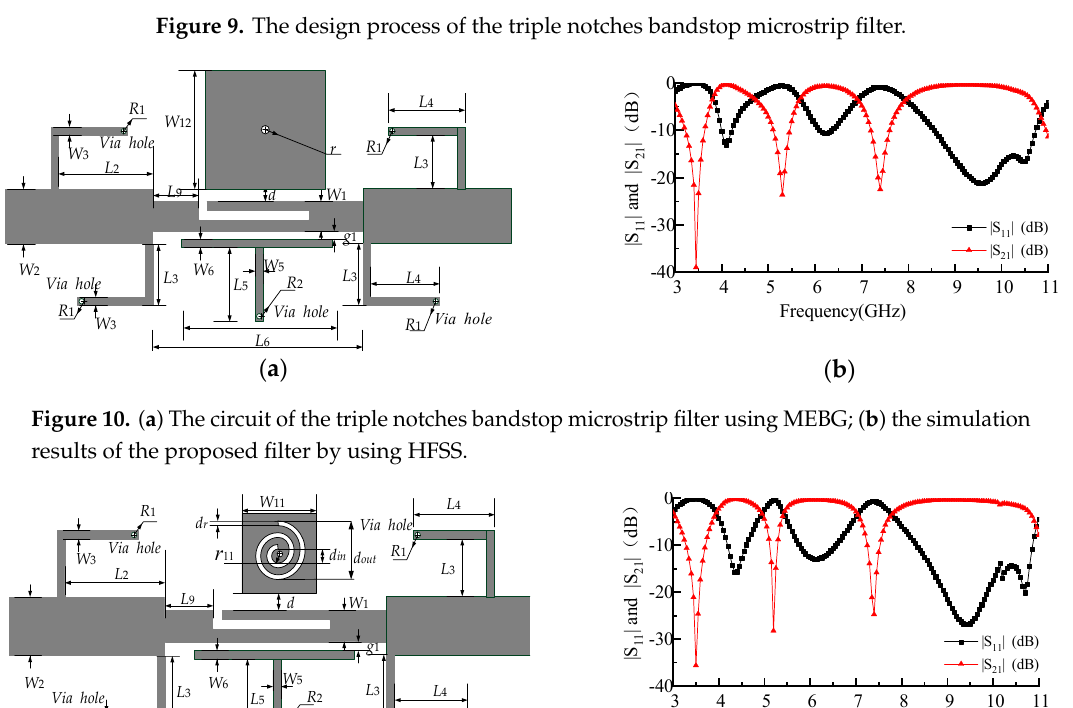
Figure 9. The design process of the triple notches bandstop microstrip filter.